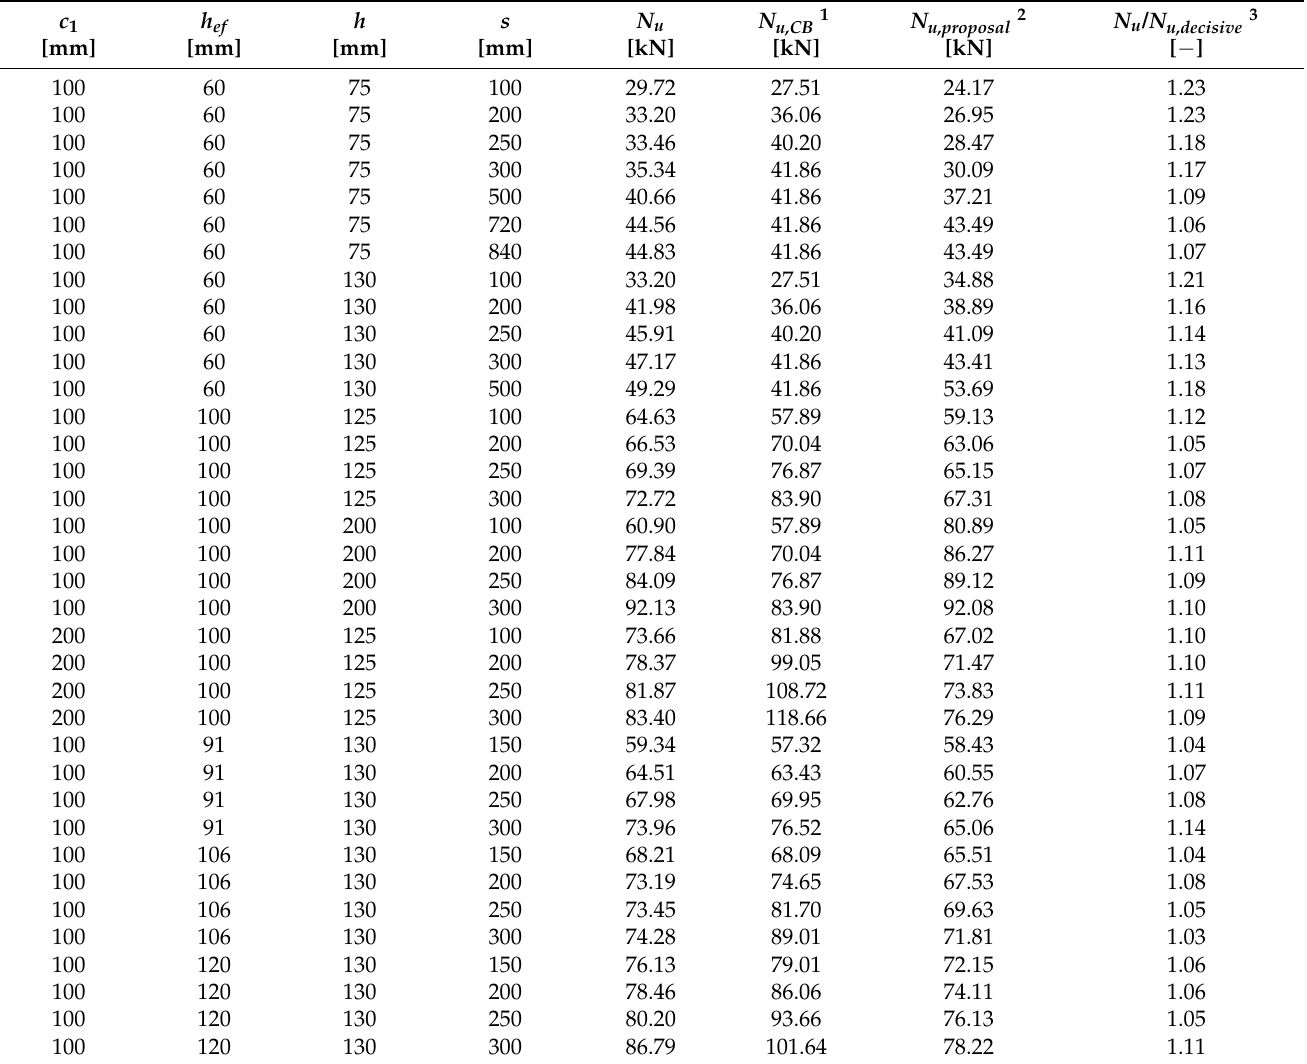
Table A3. Numerical simulations—influence of anchor